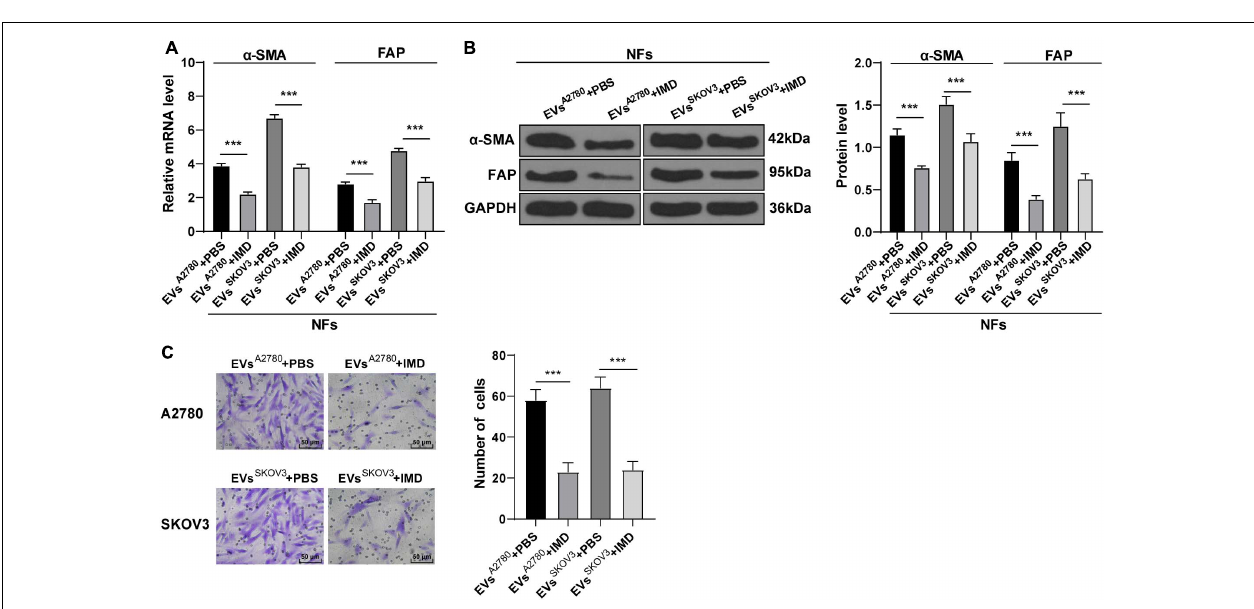
FIGURE 7 | Inhibition of NF- κ B pathway attenuated the activation of CAFs induced by EVs. NFs were co-treated with A2780 or SKOV3 cells-derived EVs and IMD-0354 or PBS. (A,B) Levels of CAFs marker proteins ( α -SMA and FAP) in NFs were detected using RT-qPCR and Western blotting. (C) Migration of NFs in each group was detected using Transwell assay; the migrated cells were counted and representative images were displayed. The experiment was repeated three times independently. Data are presented as mean ± standard deviation and analyzed using one-way ANOVA, followed by Tukey’s multiple comparisons test, *** p < 0.001. A2780 and SKOV3 indicated the source of